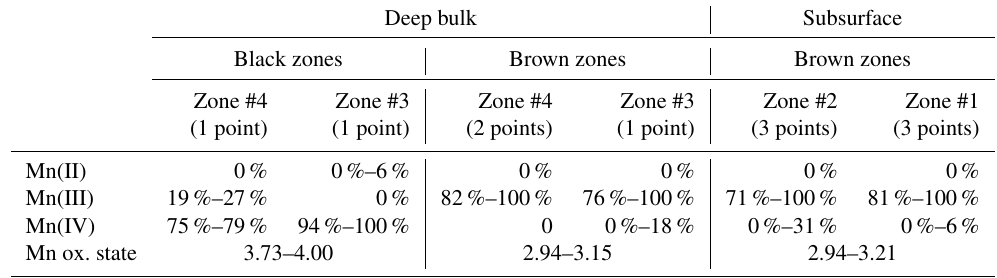
Table 4. Relative proportions of Mn(II), Mn(III), and Mn(IV) determined using the Combo method in L4 regions of interest.